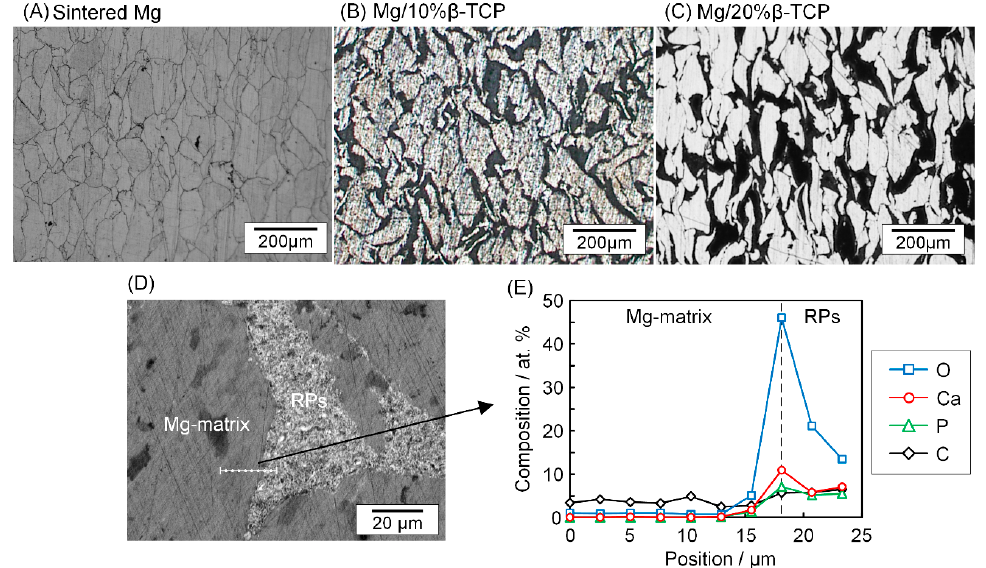
Figure 1. Optical micrographs of the ( A ) sintered Mg, ( B ) Mg/10% β -TCP, ( C ) Mg/20% β -TCP before immersion, ( D ) SEM image of the Mg/10% β -TCP showing the interface between Mg matrix and reaction products (RPs) area, and ( E ) line analysis of EDS across the interface. The balanced concentration of Mg was not shown in ( E ) ( D and E are reproduced from our previous work [34], copyright permission obtained).